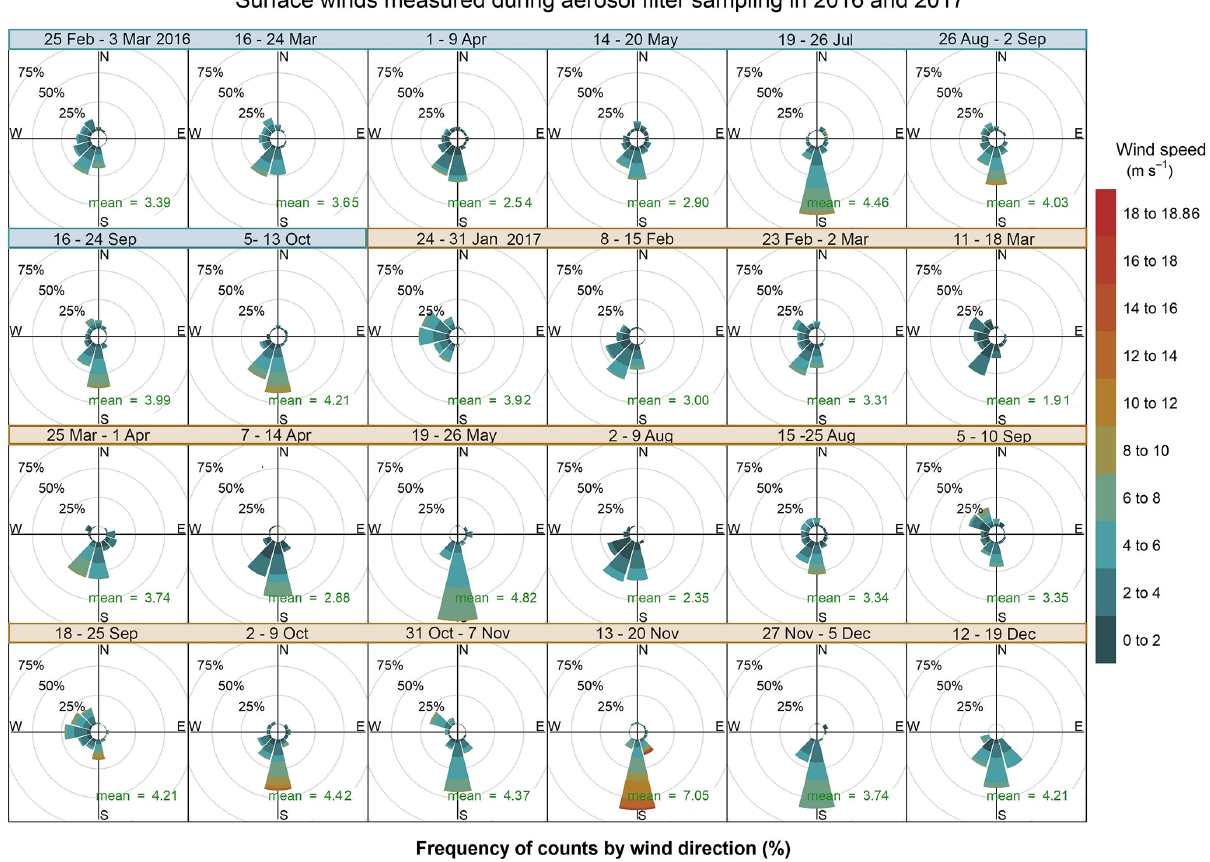
Figure 3. Wind roses showing the wind speed, direction and frequency of occurrence corresponding to each aerosol sampling week in 2016 (dates in blue) and 2017 (dates in orange). The arithmetic mean wind speed for each week is reported in green. For 7–14 July 2017 no surface wind data are